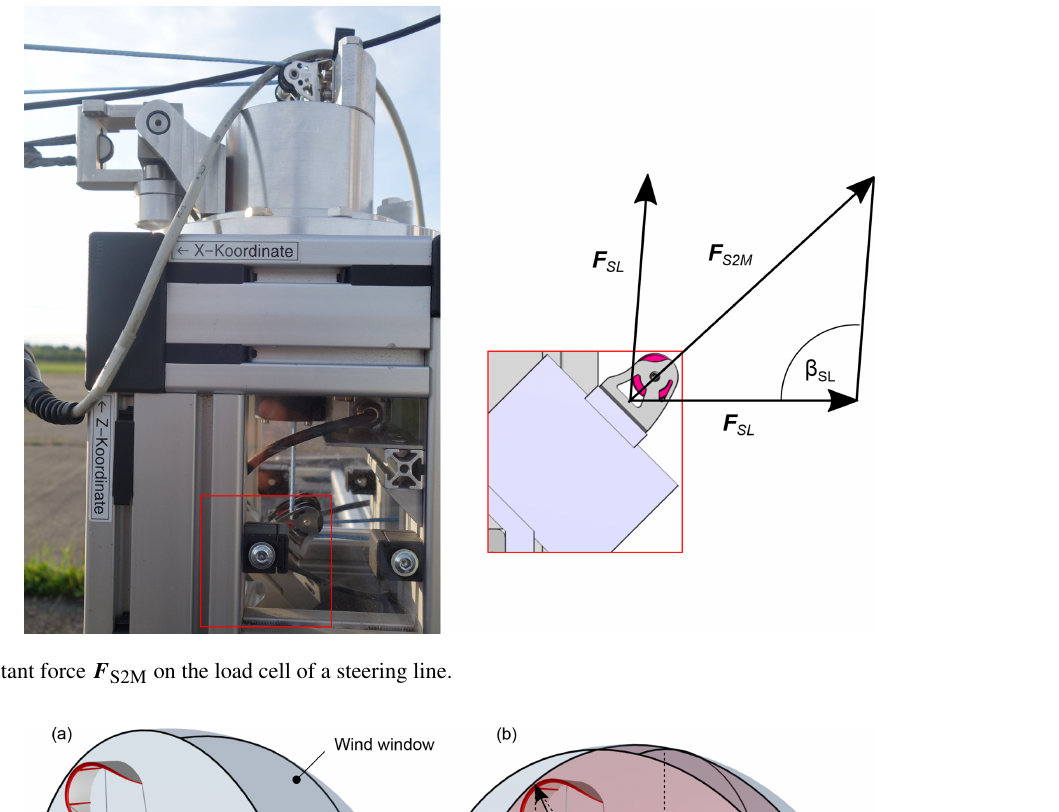
Figure 8. The resultant force F S2M on the load cell of a steering line.